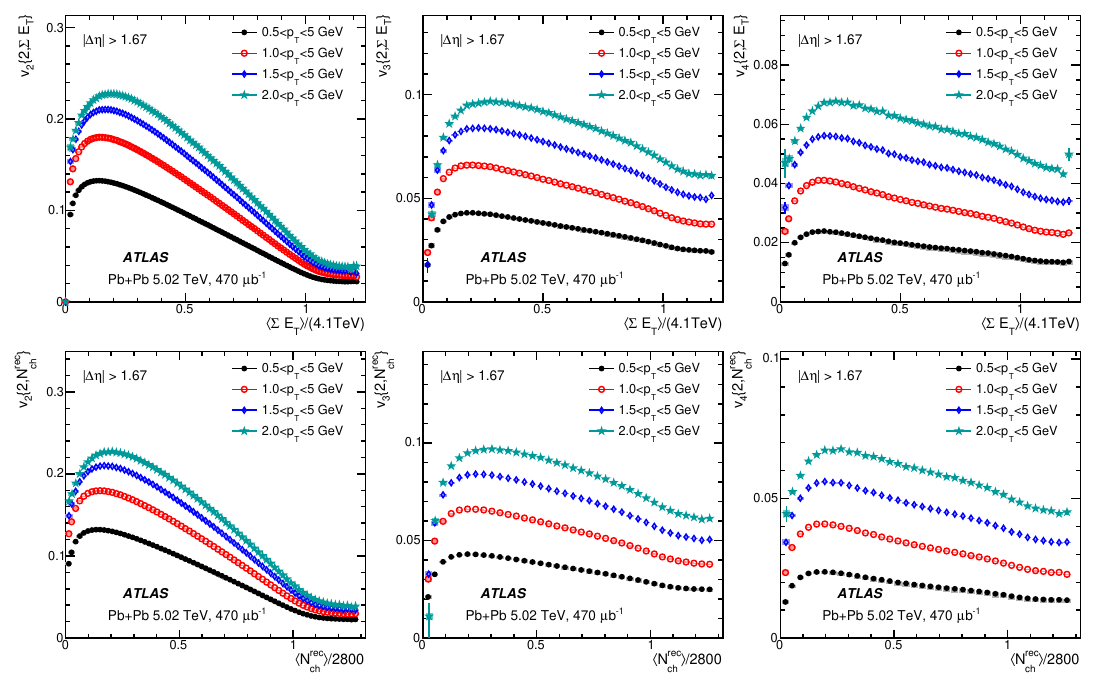
Figure 13 . The h (cid:6) E T i (top row) and h N rec i (bottom row) dependence of v 2 f 2 ; (cid:6) E T g (left panel), ch v 3 f 2 ; (cid:6) E T g (middle panel) and v 4 f 2 ; (cid:6) E T g (right panel) for four p T ranges. The error bars and shaded boxes represent the statistical and systematic uncertainties,